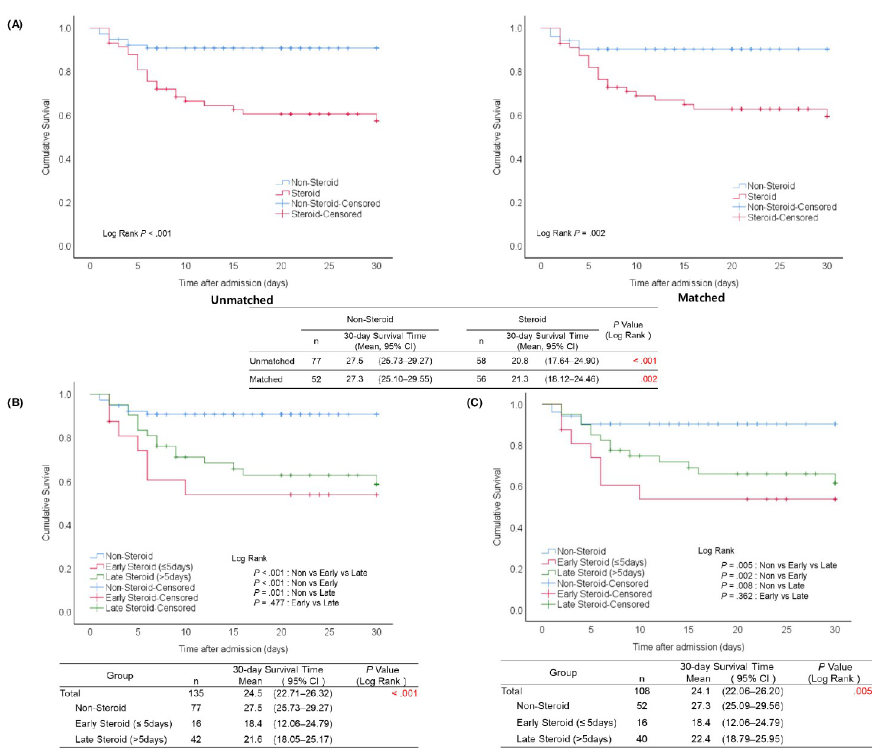
Fig 2. Survival analysis according to the timing of steroid therapy in patients with severe fever with thrombocytopenia syndrome (SFTS). (A) Kaplan–Meier analysis of 30-day survival after admission between patients with severe fever with thrombocytopenia syndrome (SFTS) with and without steroid therapy before and after propensity score matching a . (B) Kaplan–Meier analysis of 30-day survival after admission among patients with severe fever with thrombocytopenia syndrome (SFTS) with early, late, and non-steroid treatment, before propensity score matching. (C) Kaplan–Meier analysis of 30-day survival after admission among patients with severe fever with thrombocytopenia syndrome (SFTS) with early, late, and non-steroid treatment, after propensity score matching. a. There were 7 missing patients in the unmatched dataset and 4 in the matched dataset due to missing data on 30-day survival